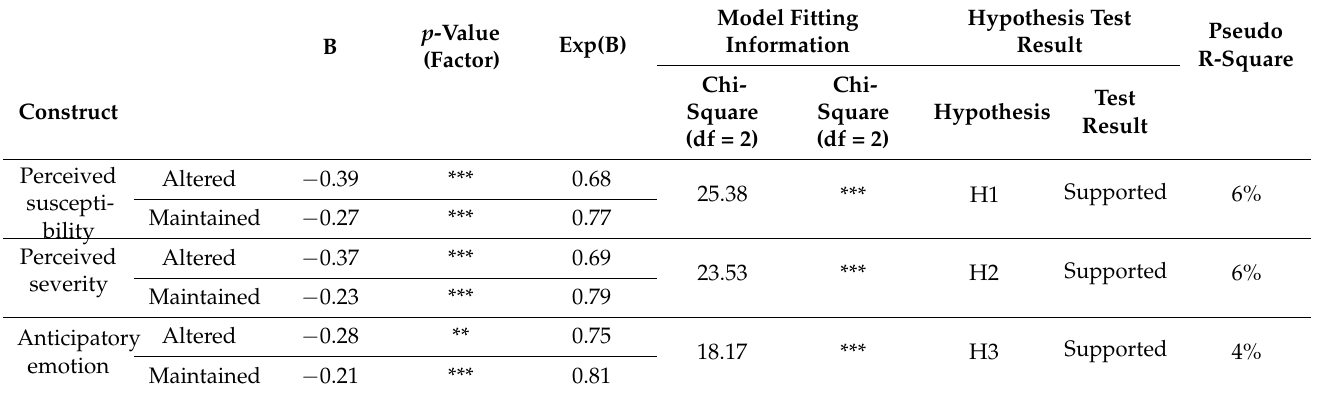
Table 6. Multinomial logistic regression